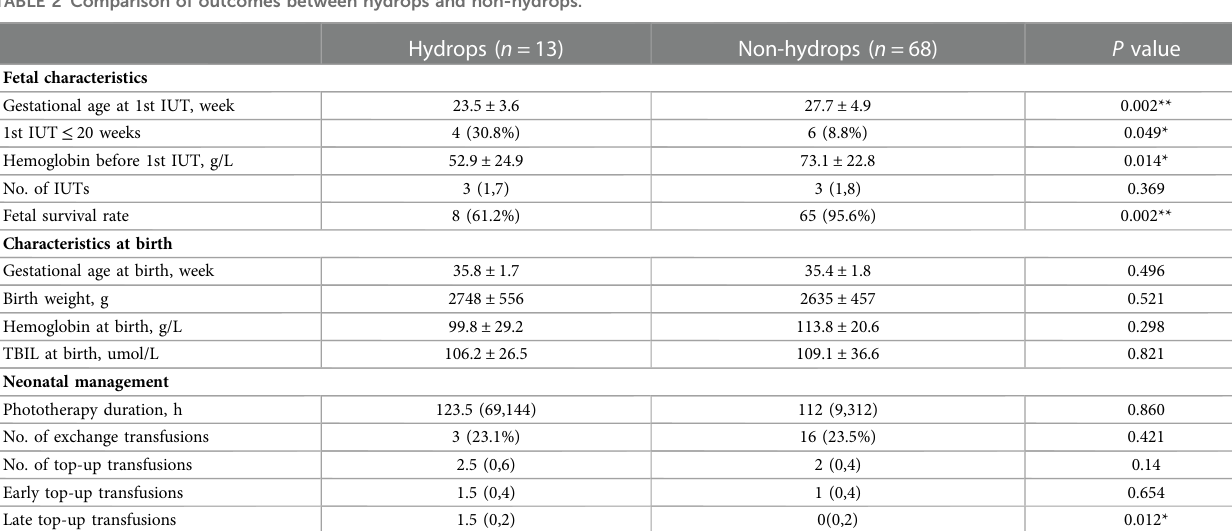
TABLE 2 Comparison of outcomes between hydrops and non-hydrops.